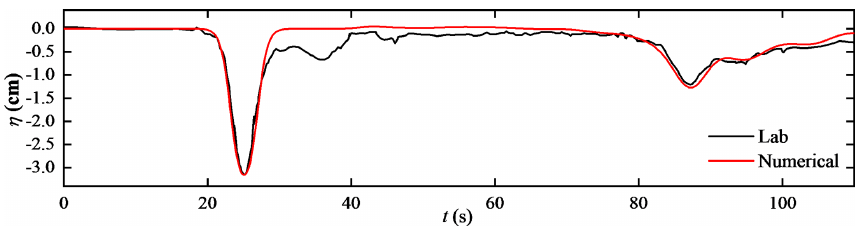
Figure 13. Time series of the interface displacement. The probe was 99.8cm away from the start of the